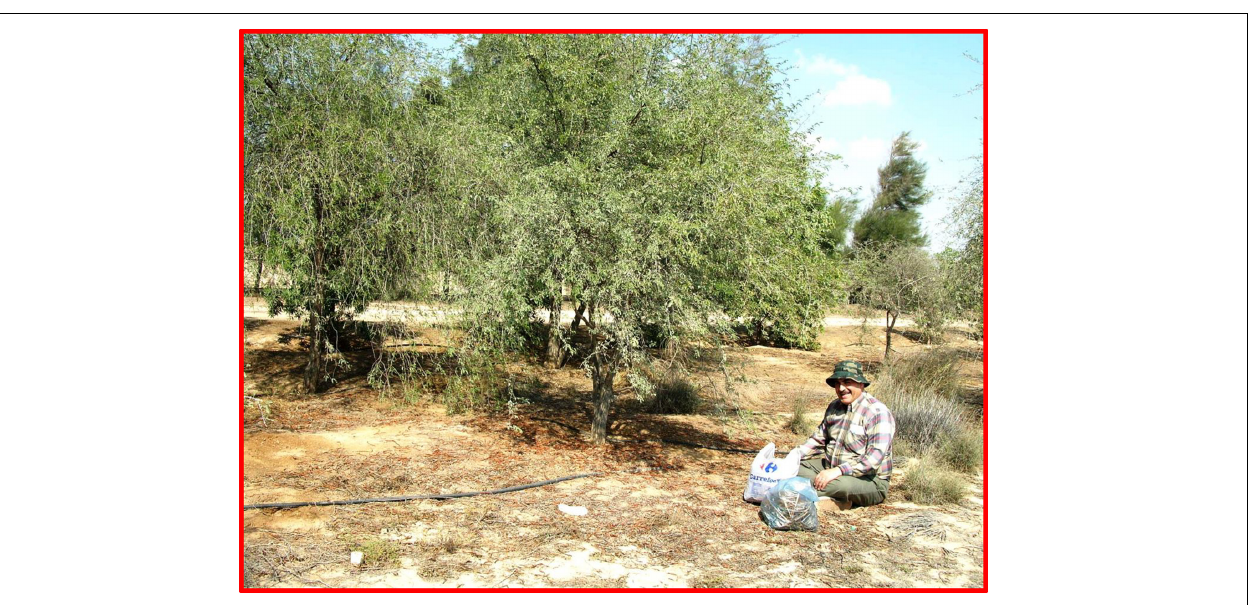
FIGURE 7 | Many trees can be found at many private farms around Qatar. The second author was sitting near Ghaf trees during one of his research trips to